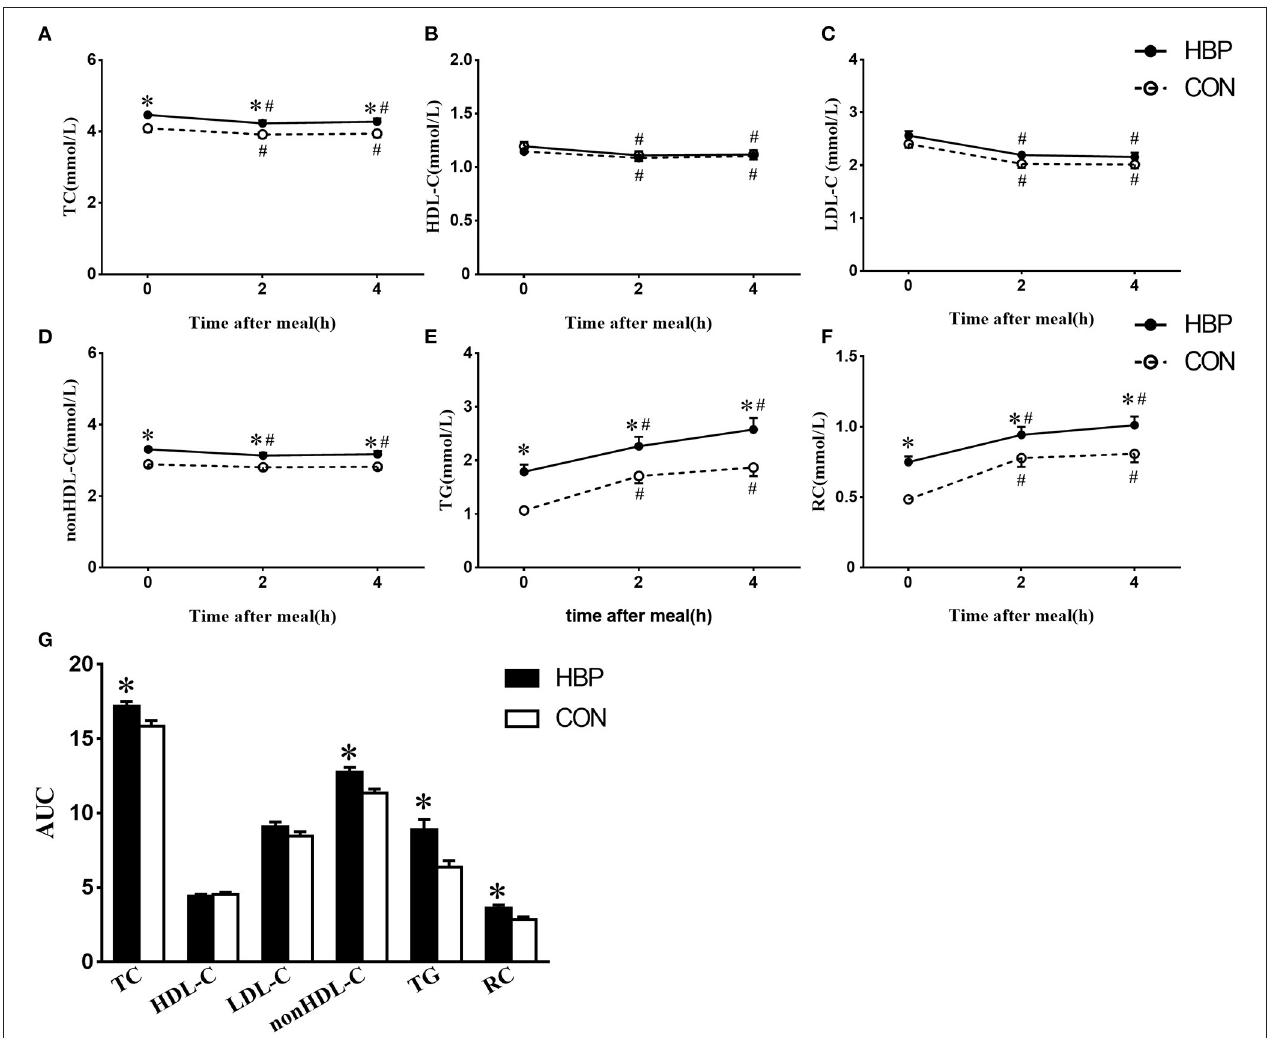
FIGURE 1 | Changes in serum levels of blood lipids after a daily meal in the two groups. (A–F) Postprandial changes in serum levels of TC, HDL-C, non–HDL-C, LDL-C, TG, and RC after a daily meal in the HBP group (solid line) and CON group (dotted line). The bar represents standard error of the mean. (G) Comparison of AUC of blood lipids after a daily meal between the two groups. * P < 0.05 when compared with the CON group at the same time point. # P < 0.05 when compared with the fasting level in the same